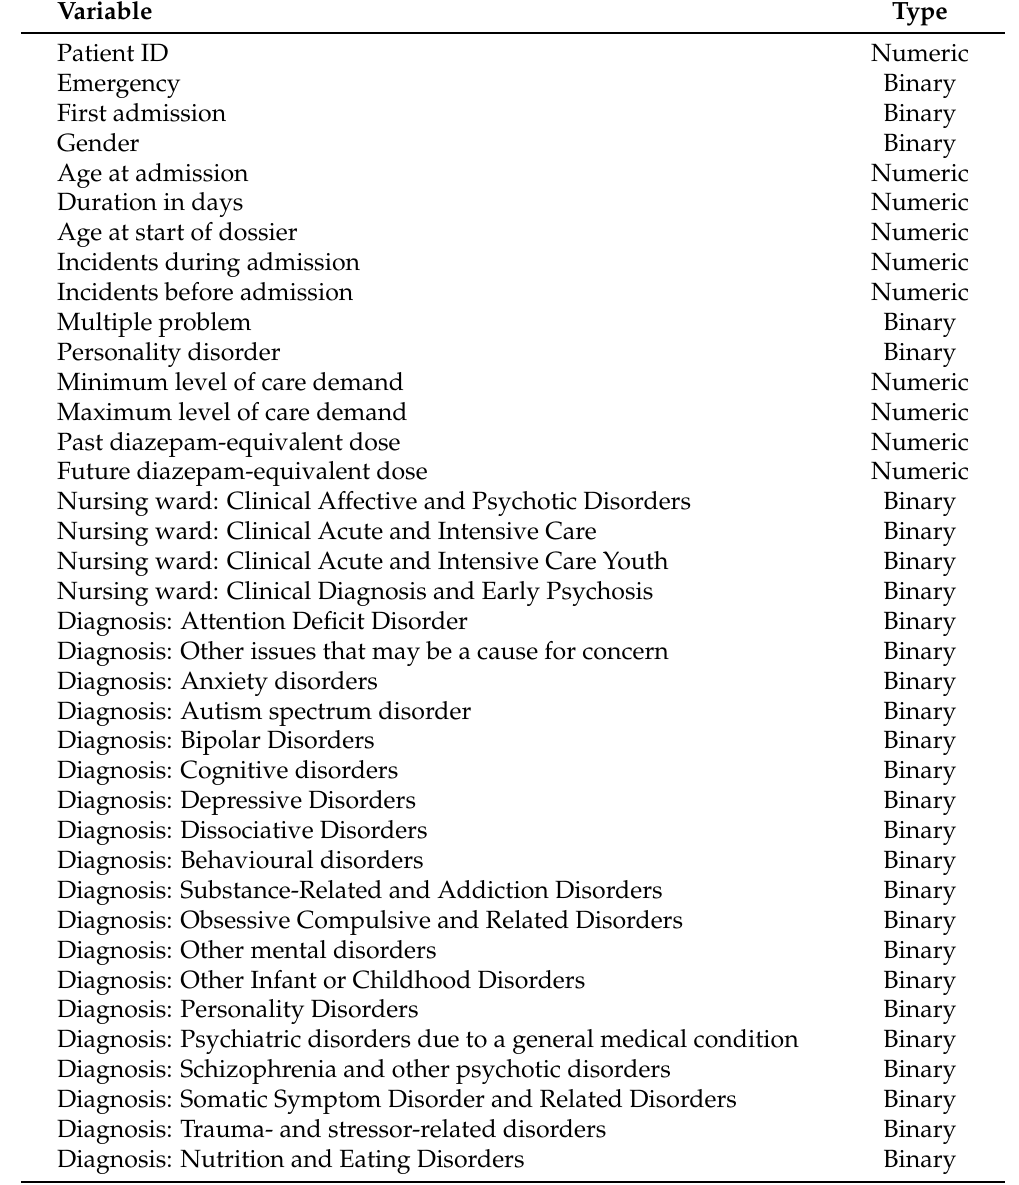
Table 3. List of variables in the final